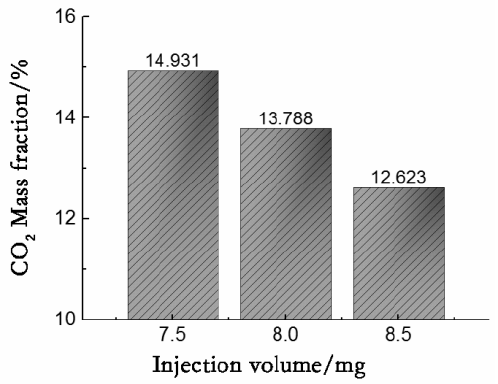
Figure 30. CO 2 data corresponding to different injection volumes.